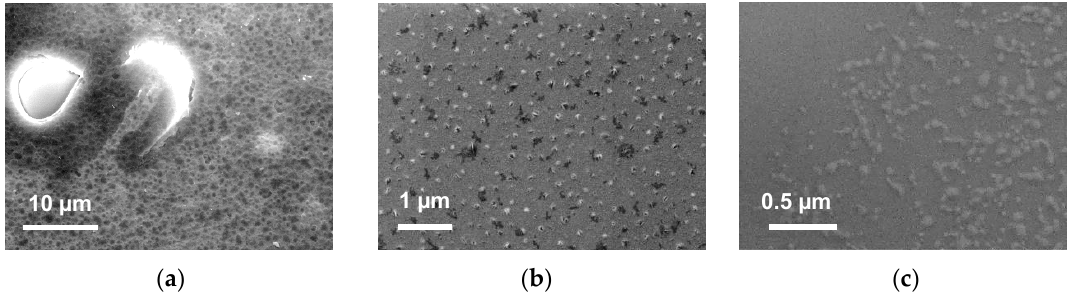
Figure 10. Top-view SEM micrographs of multilayered films with the ratio of thicknesses of MeN and